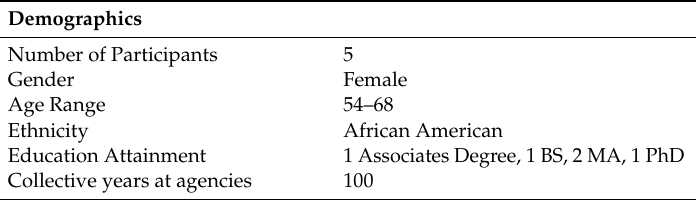
Table 1. Demographics of support group